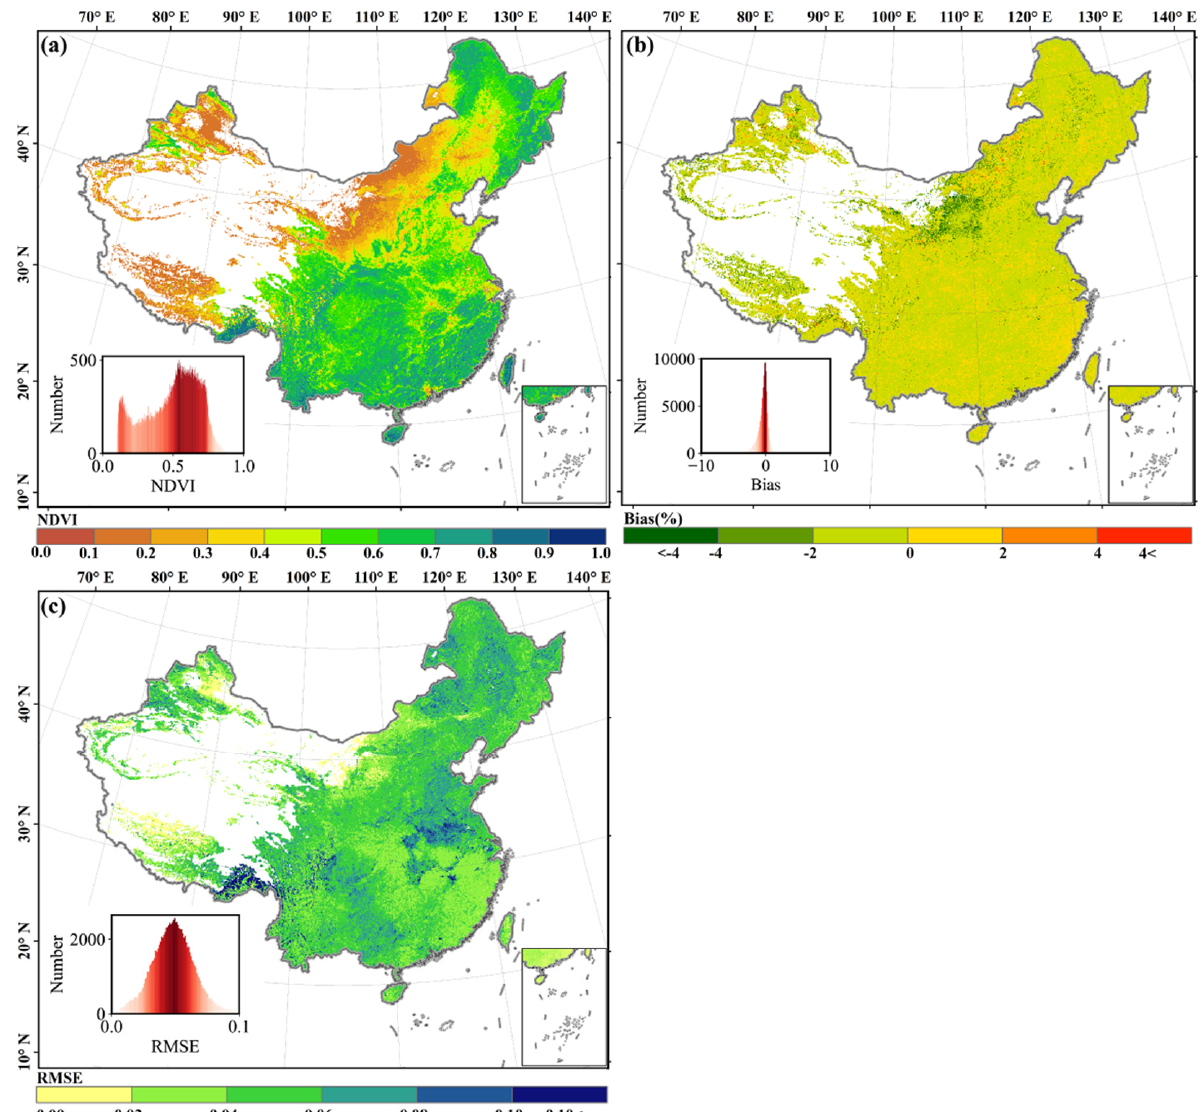
Figure 2. Spatial distribution of the simulated annual mean normalized difference vegetation index (NDVI; a ), relative predictive error (bias; b ), and root-mean-square error (RMSE; c ).